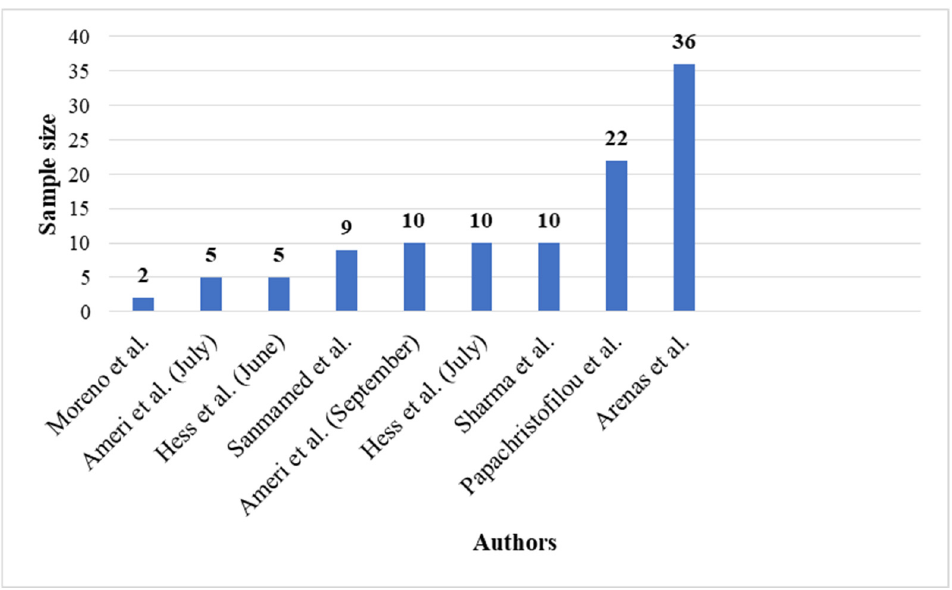
Figure 2. Sample size in the 9 investigated studies.